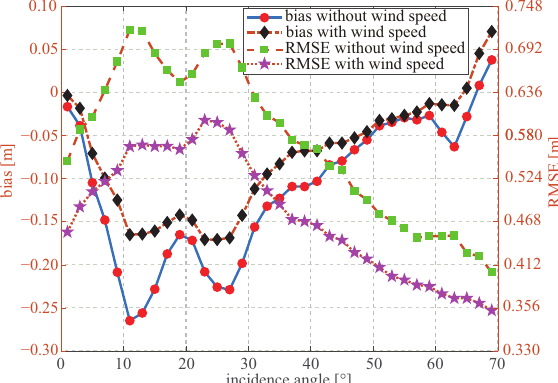
Figure 9. Biases and RMSEs between the retrieved SWH and ECMWF data at different incidence